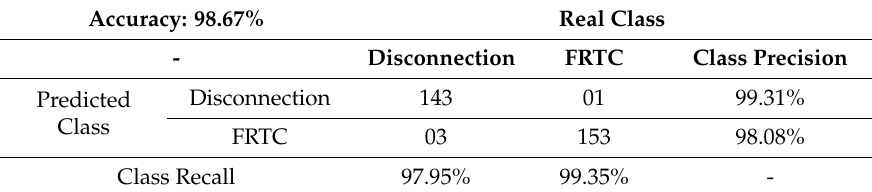
Table 4. Confusion Matrix (Fault Ride Through Capability (FRTC)).